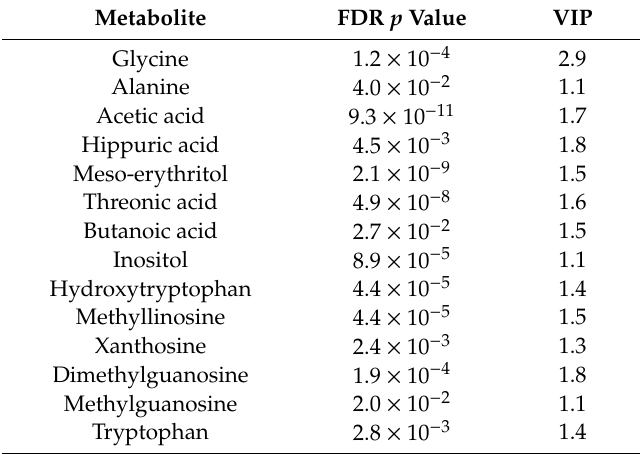
Table 1. The list of putative metabolic markers of urogenital tract cancers obtained with the use of the metabolomics